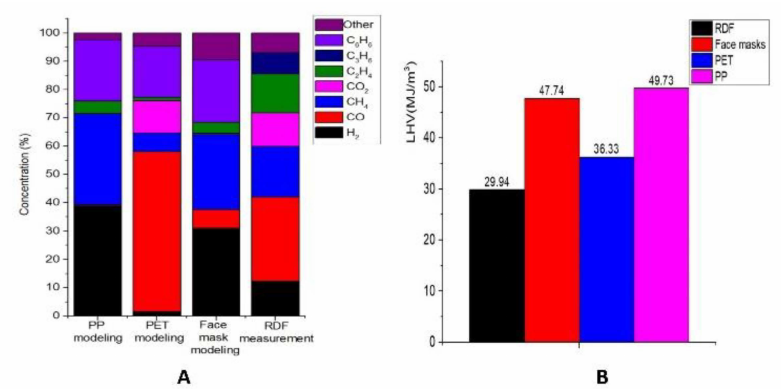
Figure 10. ( A ) Gas product distribution from thermal pyrolysis of various feedstocks. ( B ) Calorific quantities of gas products from thermal pyrolysis of various feedstocks. RDF represents refuse- derived fuel. Reproduced with permission from Ref. [66]. Copyright 2022 The Authors. Published by